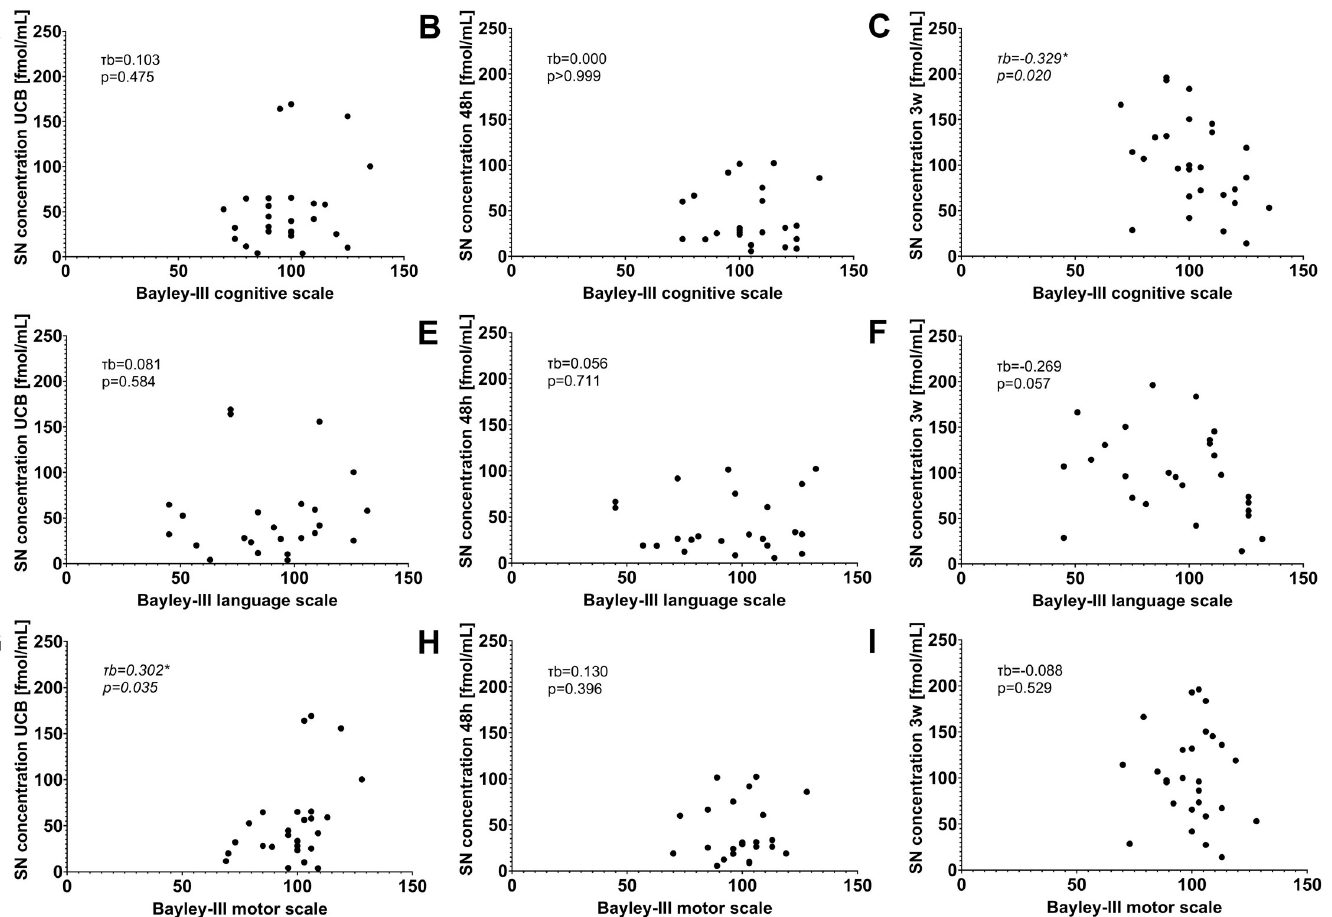
Fig 6. Correlation of secretoneurin (SN) serum concentrations with Bayley Scales of Infant and Toddler Development, third edition (Bayley-III) assessed at a corrected age of 2 years. Composite scores for the cognitive scale (A-C), the language scale (D-F), and the motor scale (G-I) are presented. SN concentrations were measured in umbilical cord blood (UCB) (A, D, G) and in blood samples collected at 48 hours (48h) (B, E, H) and 3 weeks (3w) of life (C, F, I). Associations between two variables were assessed by means of Kendall’s tau-b ( τ b) correlation coefficient. Significance level was set at p < 0.05. Significant correlations were detected for SN concentrations measured in UCB and Bayley-III motor scale scores as well as SN concentrations determined at 3w and Bayley-III cognitive scale scores. SN concentrations are depicted in fmol/mL.